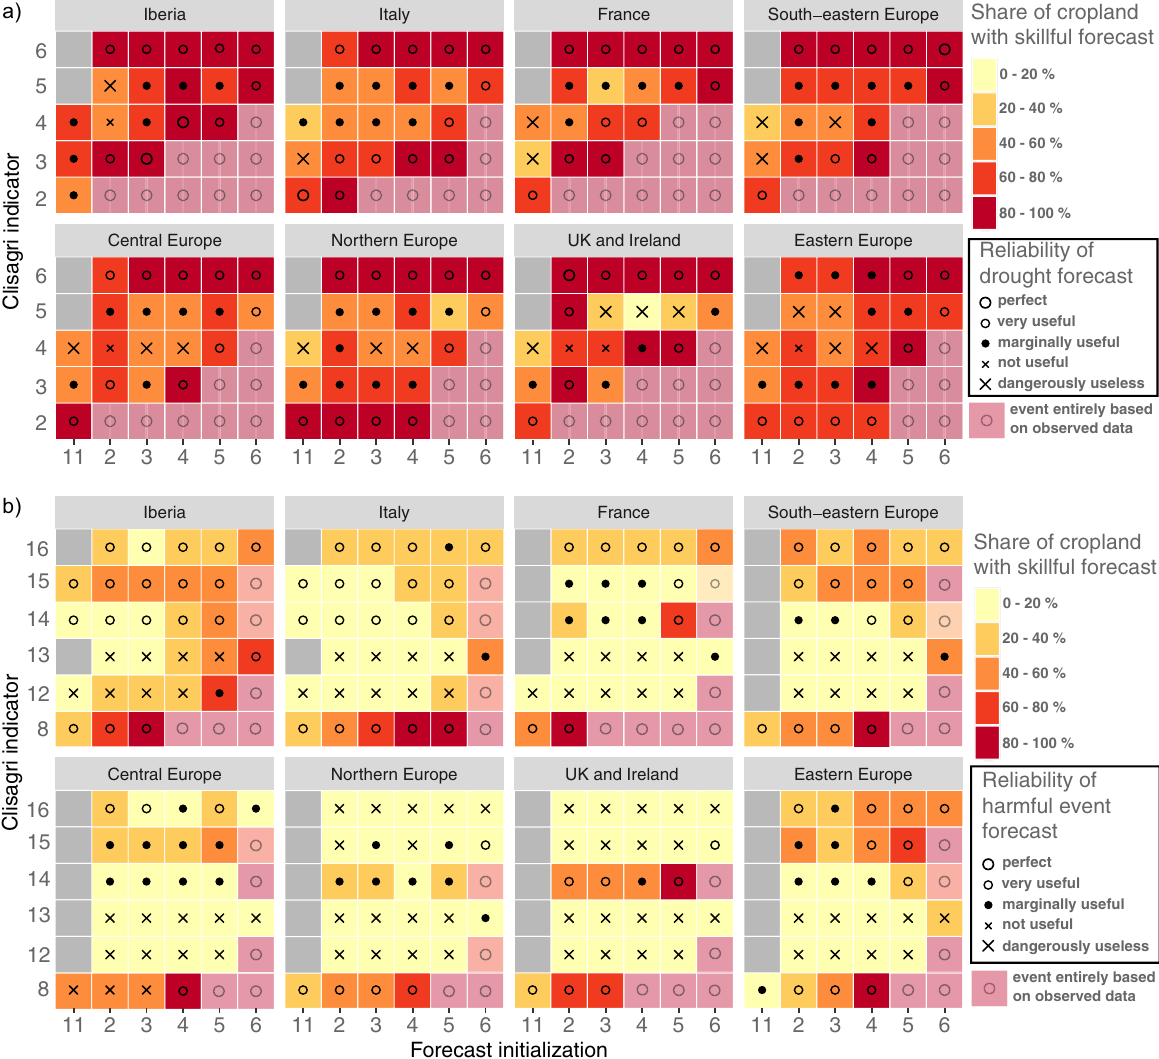
Fig. 2 European arable land with skillful predictions. a Share of arable land in the selected regions of Europe where seasonal prediction of different hydrological balance indicators ( y -axis) is skillful. Symbols represent the reliability of drought (i.e., SPEI < – 0.84) seasonal predictions. The hydrological balance indicators are based on the SPEI and are calculated for different wheat growth stages. Gray areas are associated with indicators that cannot be predicted due to the too short lead time to reach maturity. b Same as a , but for excessive wetness and temperature stress indicators. Reliability is estimated for events corresponding to the third category representing overly wet and hot